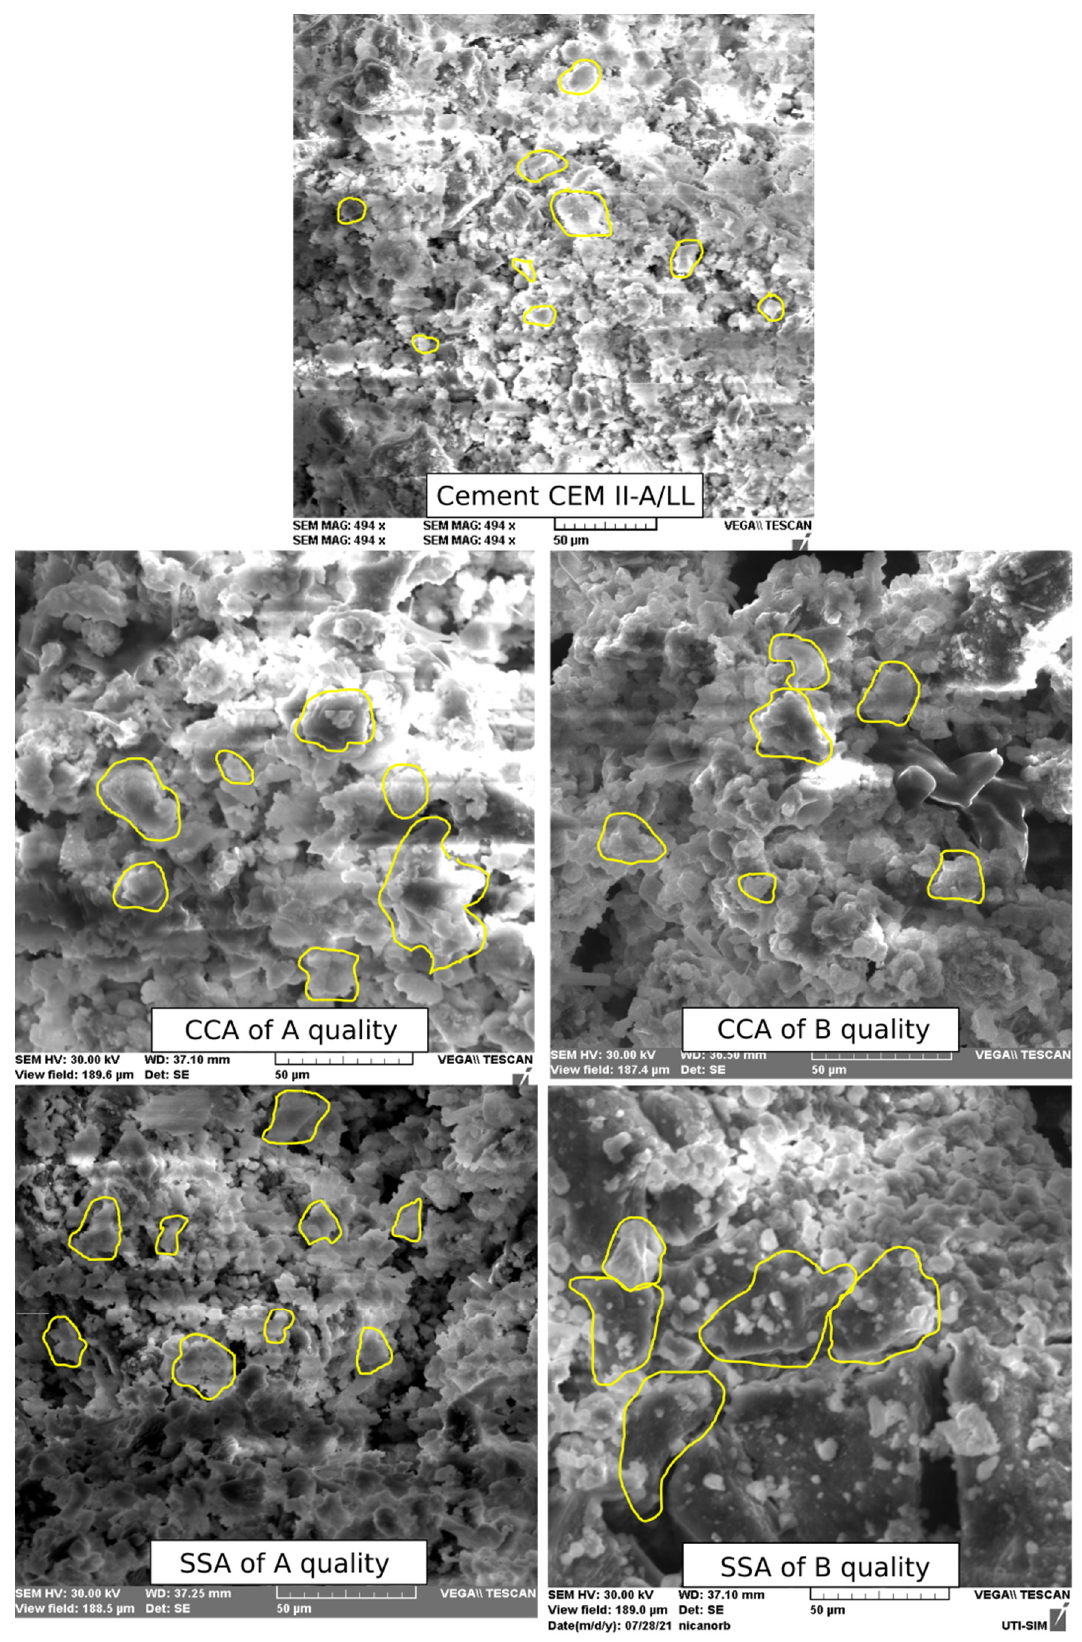
Figure 3. SEM images of CCA, SSA and cement at the magnification rate of 50 µm.